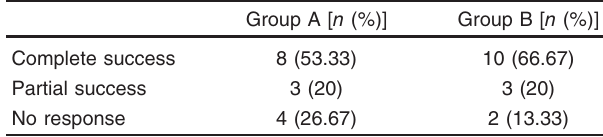
Table 6 Degree of airway patency after 3 weeks in each group Table 7 Complications in both